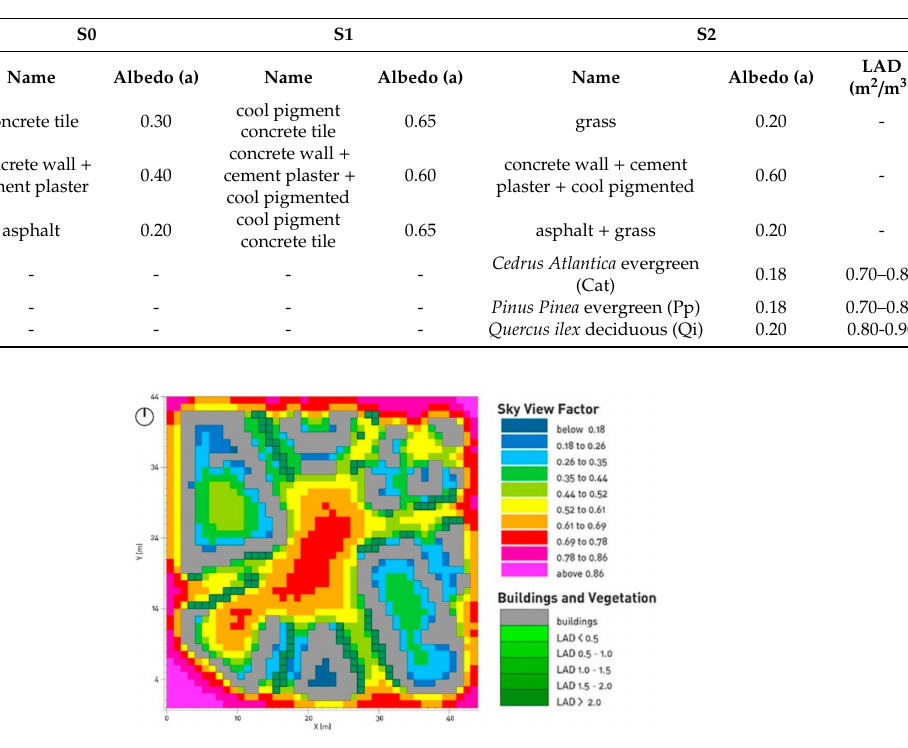
Table 2. Materials and vegetation settings for the di ff erent scenarios: S0, S1, S2.